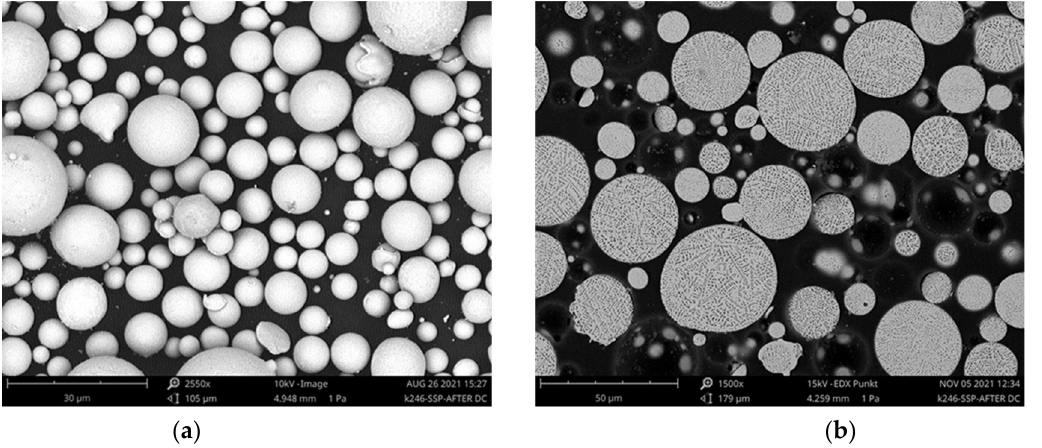
Figure 3. SEM images of the powder used: ( a ) the powder as delivered and ( b ) the microstructure of the particles.